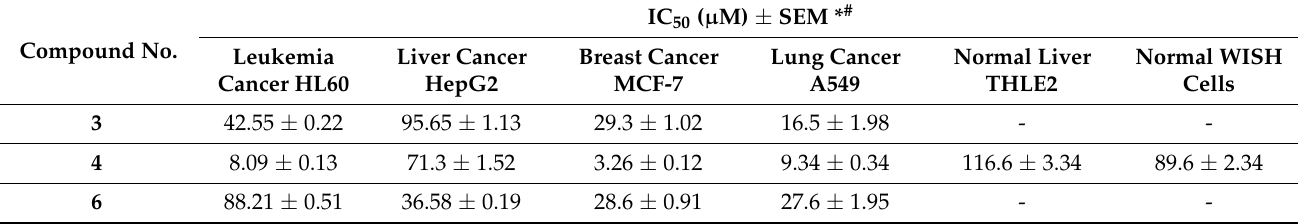
Table 1. Summary of the IC 50 ( µ M) values of the tested derivatives against a panel of cancer cells. Compound No.